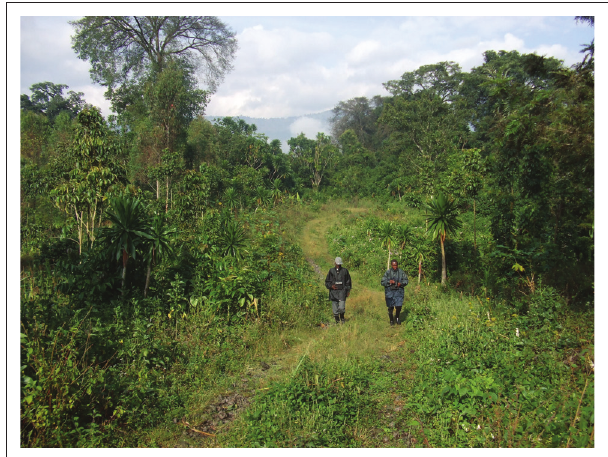
FIGURE 1: View of Buhanga sacred